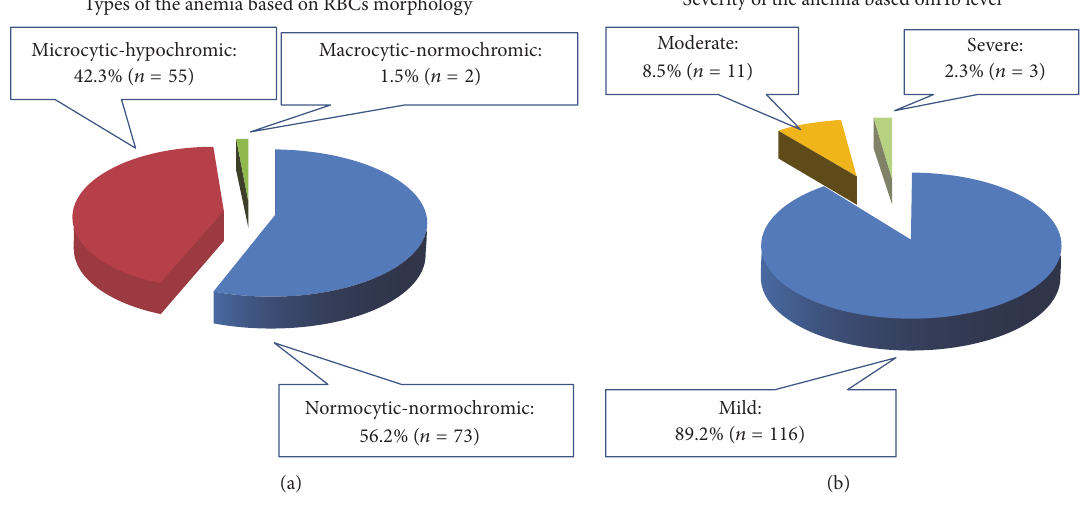
Ababa Ethiopia [32] might also have brought the